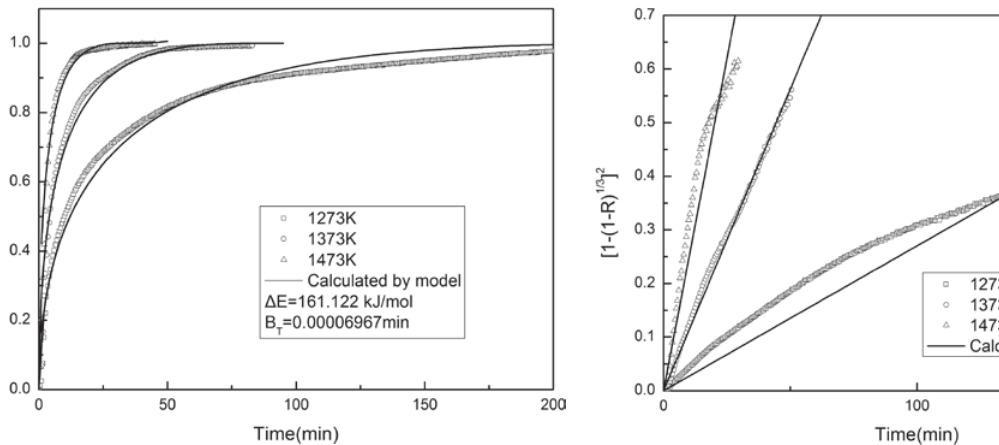
Fig. 6: Plots of [1 − (1 − R ) 1/3 ] 2 vs. time for reaction of Fe 2 O 3 and BaCO 3 at different